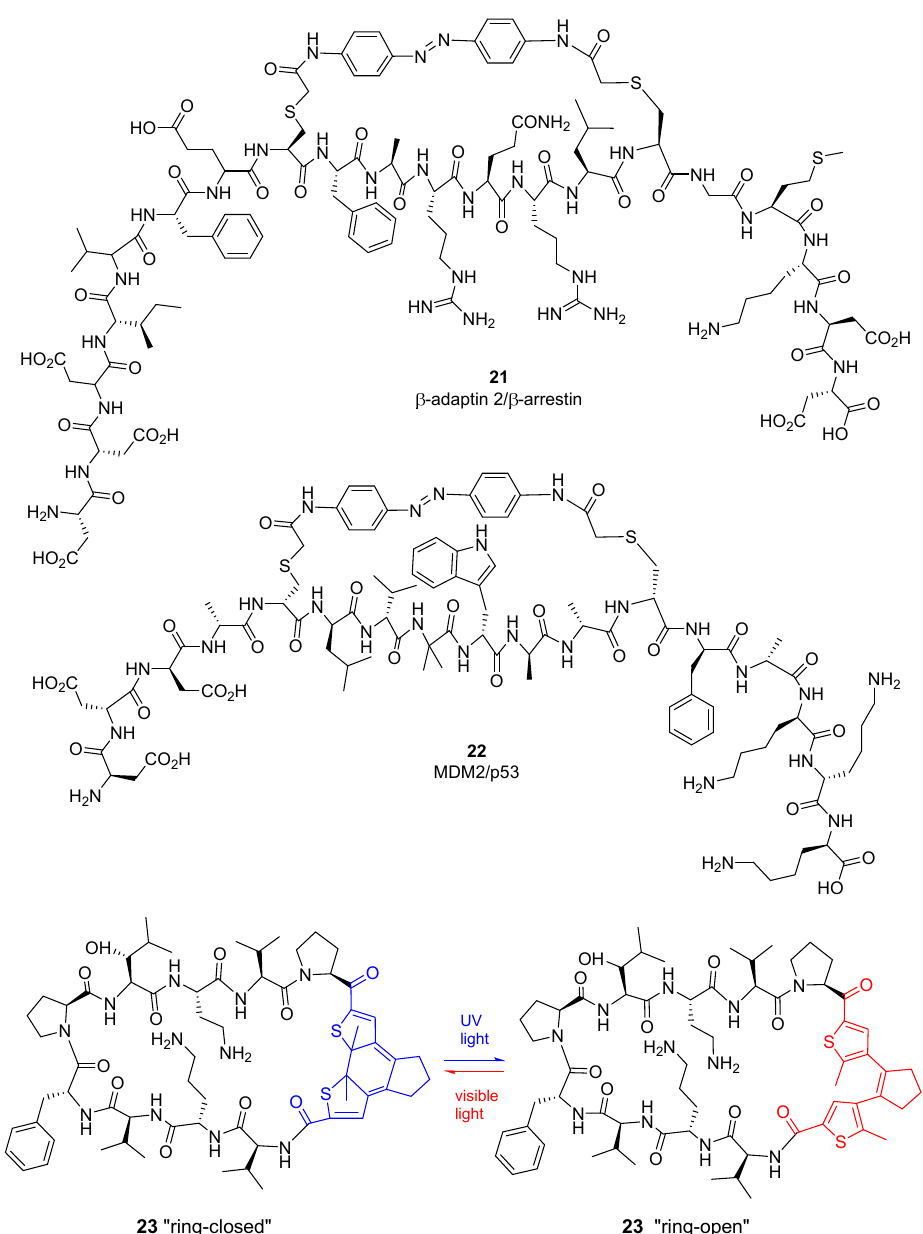
Figure 6. Selected examples of photoswitchable cyclic peptides.